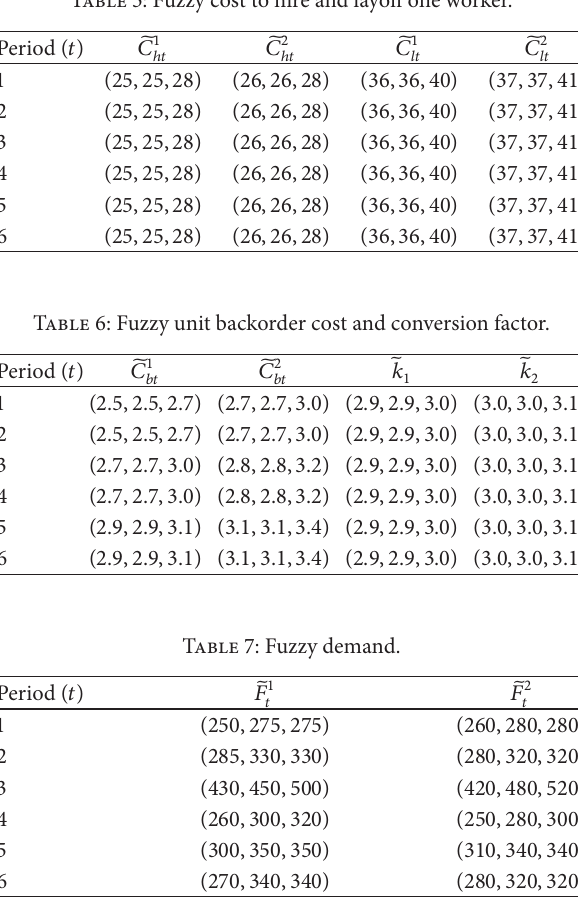
Table 5: Fuzzy cost to hire and layoff one worker.